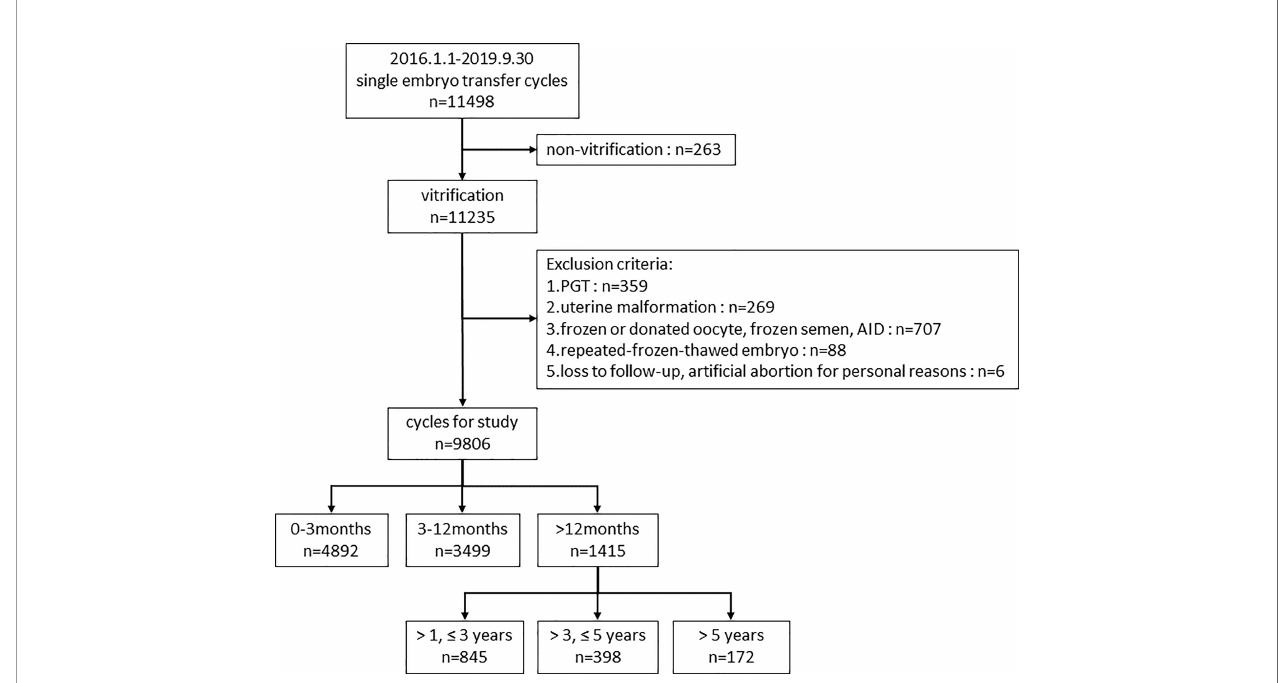
FIGURE 1 | Flow chart of the study design. PGT, preimplantation genetic testing; AID, arti fi cial insemination with donor